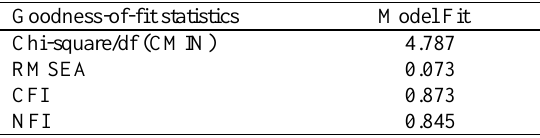
Table 3: Test Results of Model Fit Goodness-of-fit statistics Model Fit